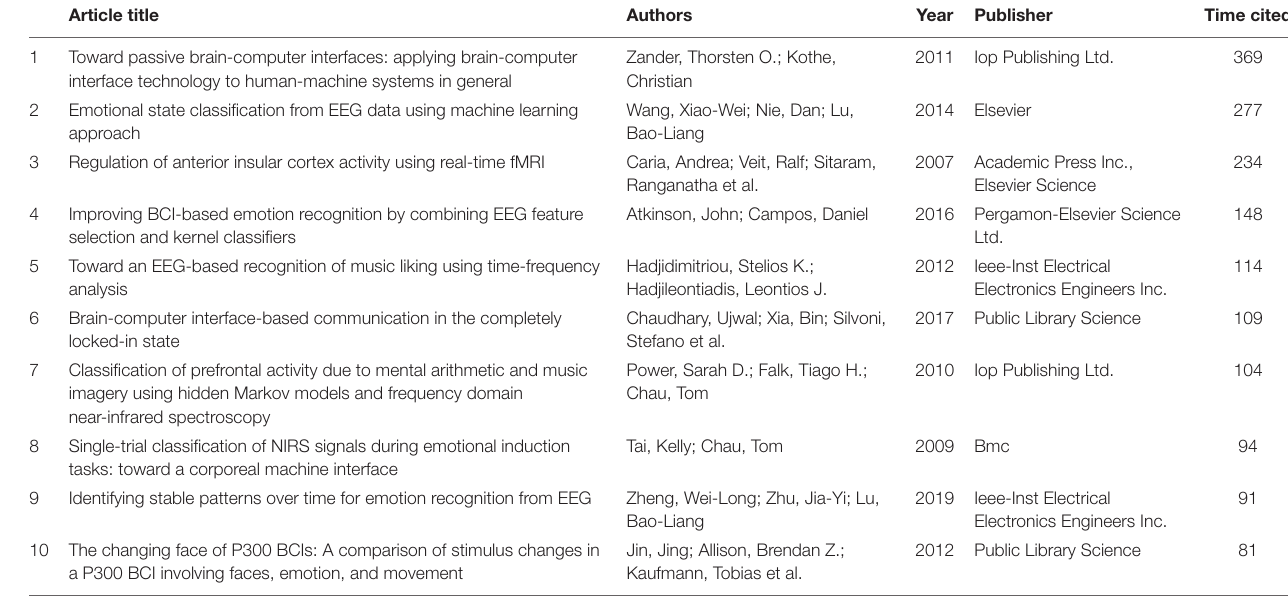
FIGURE 4 | Authors cooperation networks in BCI and emotions research. TABLE 2 | The most cited papers in BCI and emotion